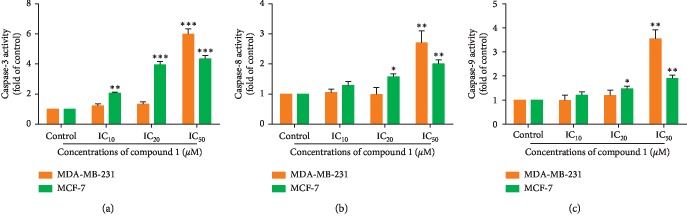
Caspase-3, caspase-8, and caspase-9 activities of MDA-MB-231 and MCF-7 cells after treatment with compound 1 for 24 hours. The caspase-3 (a), caspase-8 (b), and caspase-9 (c) activities were measured by using individual specific tetrapeptide substrates tagged with para-nitroaniline, and the absorbance of cleaved p-NA was determined by a spectrophotometric microplate reader. The statistical significance value compared to the control (without treatment) is marked with asterisks, ∗p < 0.05, ∗∗p < 0.01, and ∗∗∗p < 0.001.